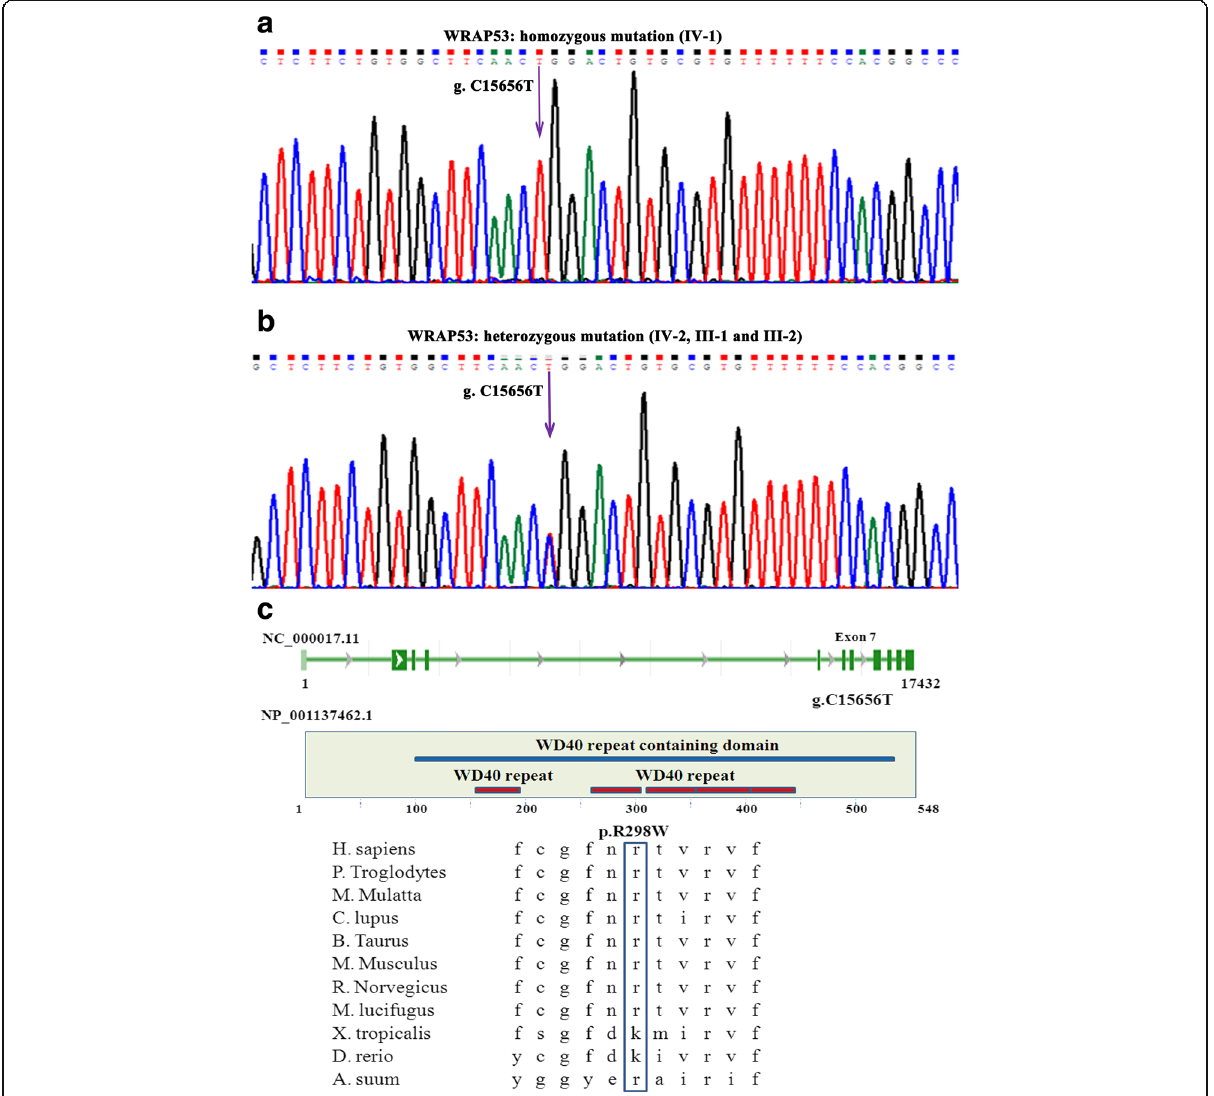
Fig. 2 a Direct sequencing of the WRAP53 gene identified a homozygous mutation (c.C892T, p.R298W) in the proband with DC. b Direct sequencing of the WRAP53 gene revealed that the proband ’ s parents and sister harbored the heterozygous mutation. c (Top) Location of the mutated nucleotides in the scheme of the WRAP53 nucleotide structure. (Middle) Location of the mutated amino acid in the scheme of the WRAP53 protein structure. (Bottom) Multi-species sequence comparison of WRAP53 shows that R298 is evolutionarily